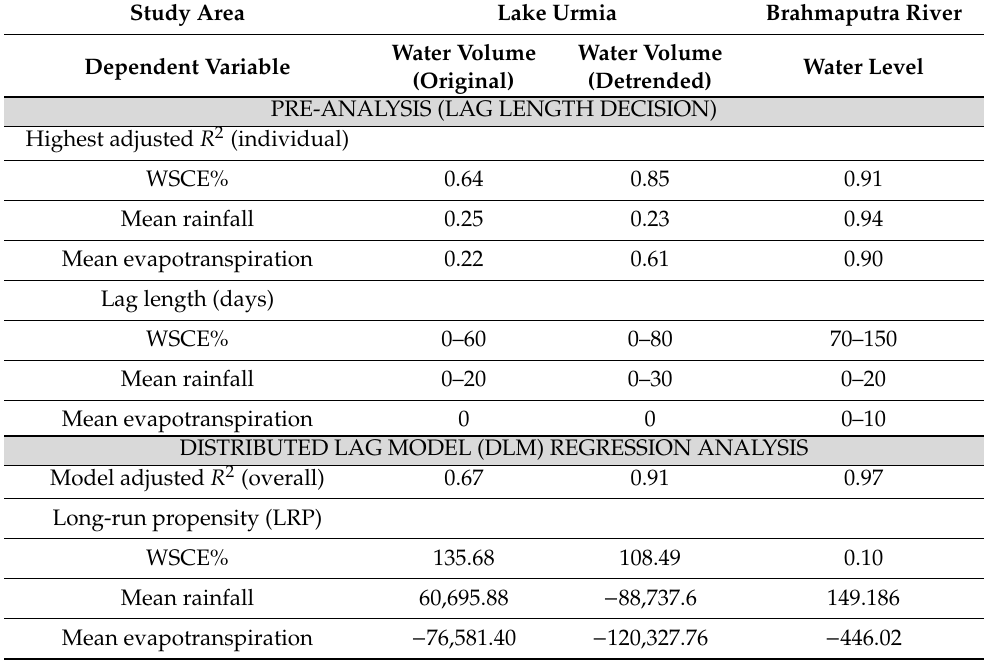
Table 1. The summaries of the distributed lag model (DLM) analysis of Lake Urmia and the Brahmaputra River. WSCE: wet snow cover